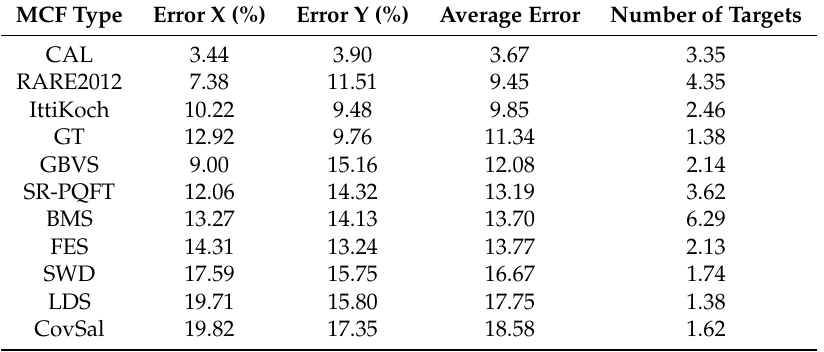
Table 11. Average errors for various saliency models taking MCF DIR and removalPercent =